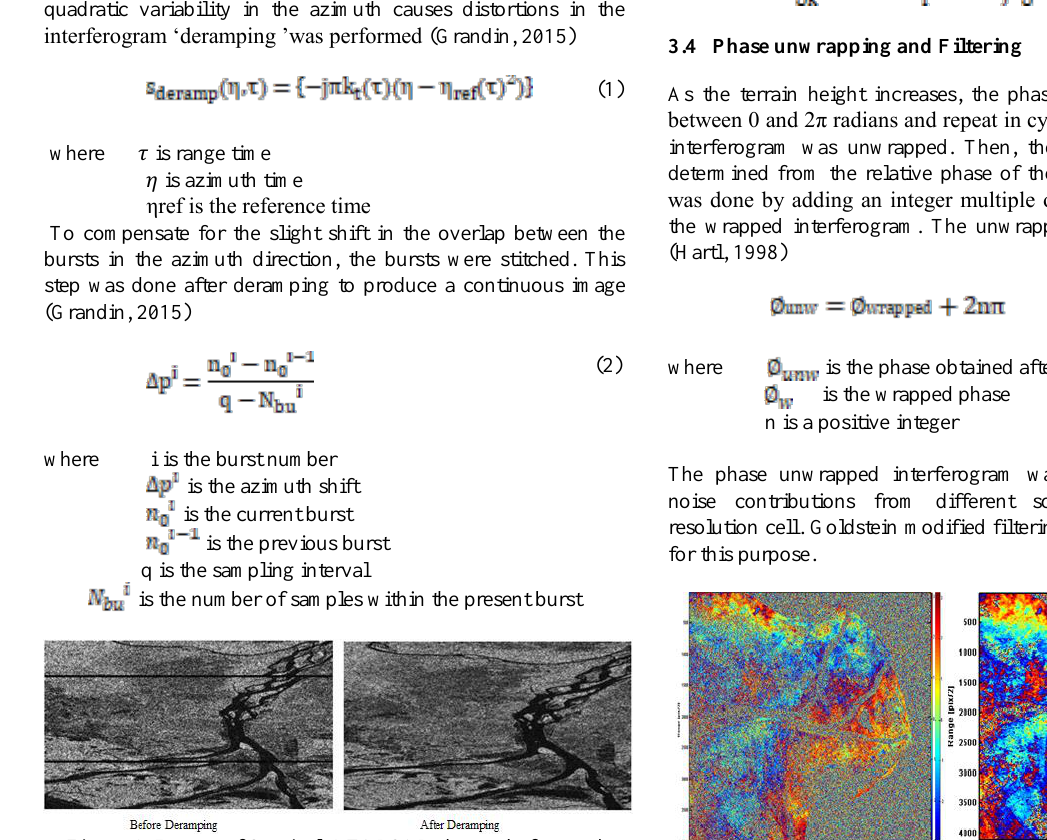
Figure 4: Images of Sentinel-1 TOPSAR dataset before and after deramping